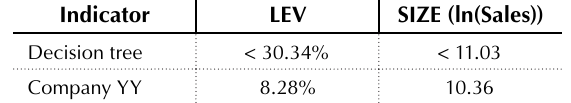
Table 9. Parameters of company ZZ compared to the decision tree conditions for Cluster